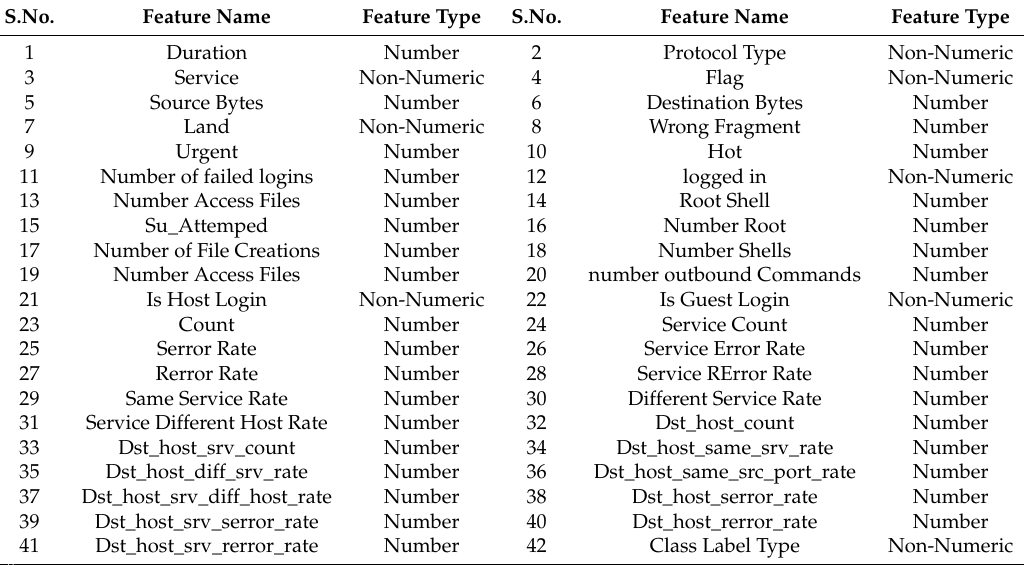
Table 7. Total number of features for KDD99 and NSLKDD